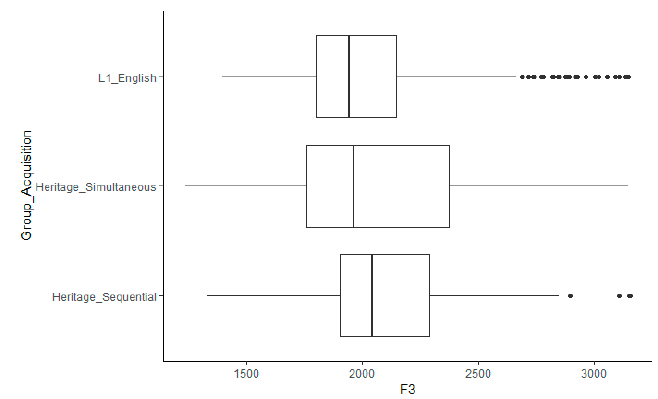
Figure 5. Boxplot for F3 value of the alveolar approximant according to participant group.